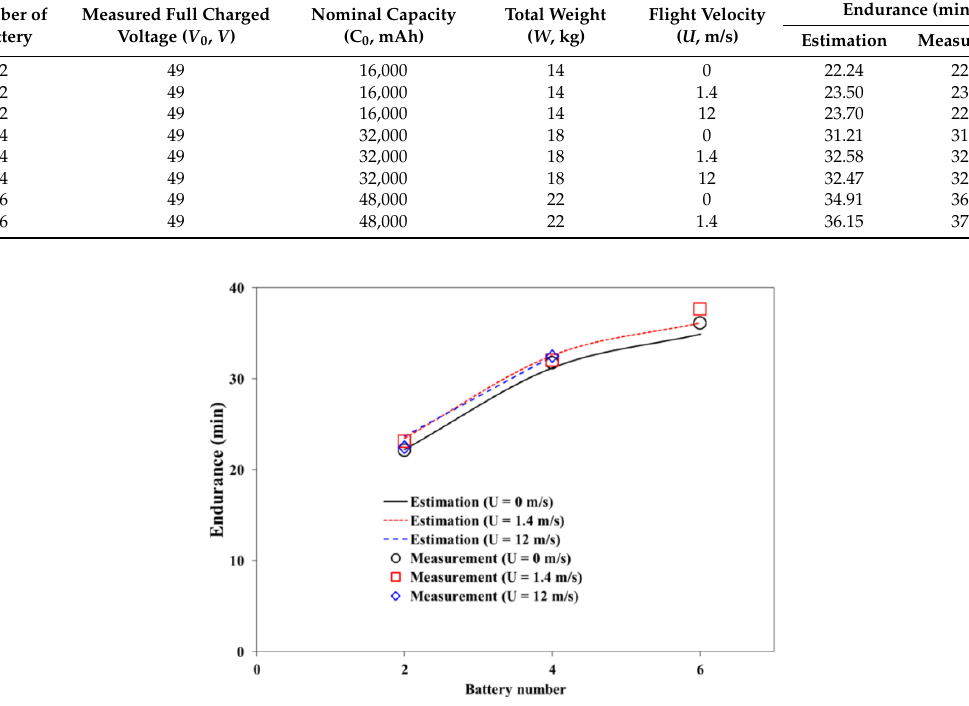
Figure 9. Experimental validation of the proposed method.